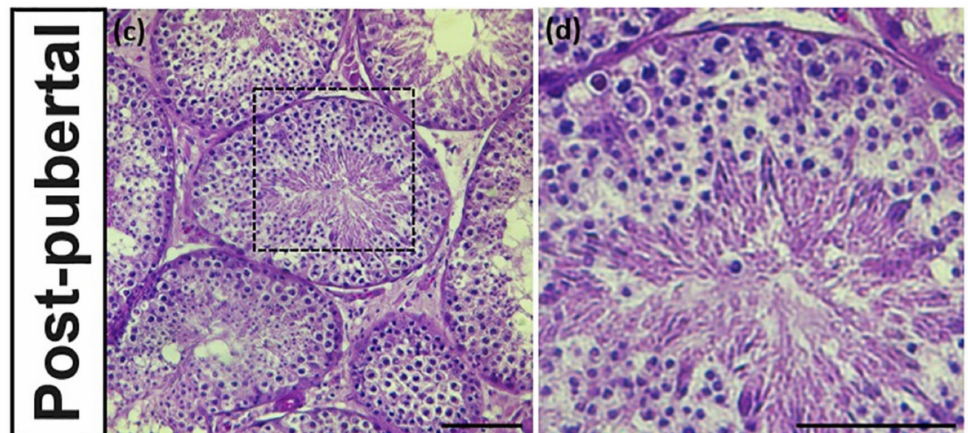
Figure 2. Morphological characteristics of seminiferous tubules of pre- and post-pubertal donkey with H&E staining. Pre-pubertal donkey testes had undeveloped seminiferous tubules with lumen closing ( a , b ). In contrast, post-pubertal donkeys had all developmental stage of germ cells with lumen opening gin the seminiferous tubules ( c,d ). The size bar = 50 µ m.